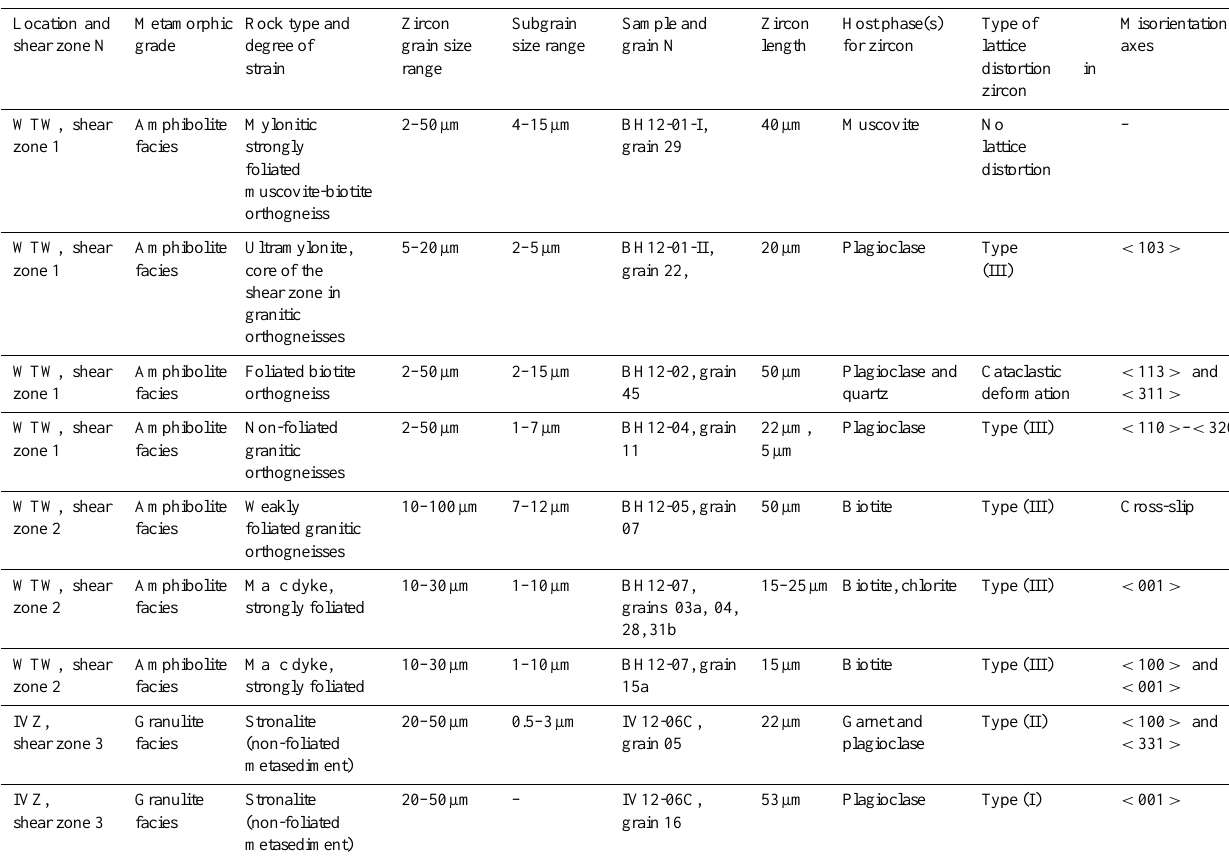
Table 1. List of samples and zircon grains discussed in this study, basic information. WTW: Western Tauern Window; IVZ: Ivrea–Verbano